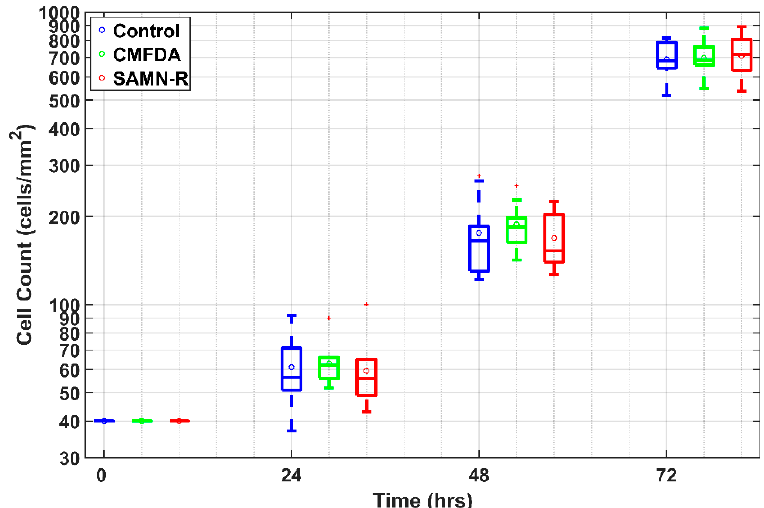
Figure 5. 3T3 cell growth. Each box represents the number of cells in an area of 1 mm 2 from 10 experiments. Each box plots the 25th and 75th percentiles. The circle inside the box is the mean, the band inside the box is the median. Whiskers (the most extreme values not considered as outliers) and outliers (red squares) are outside the box.